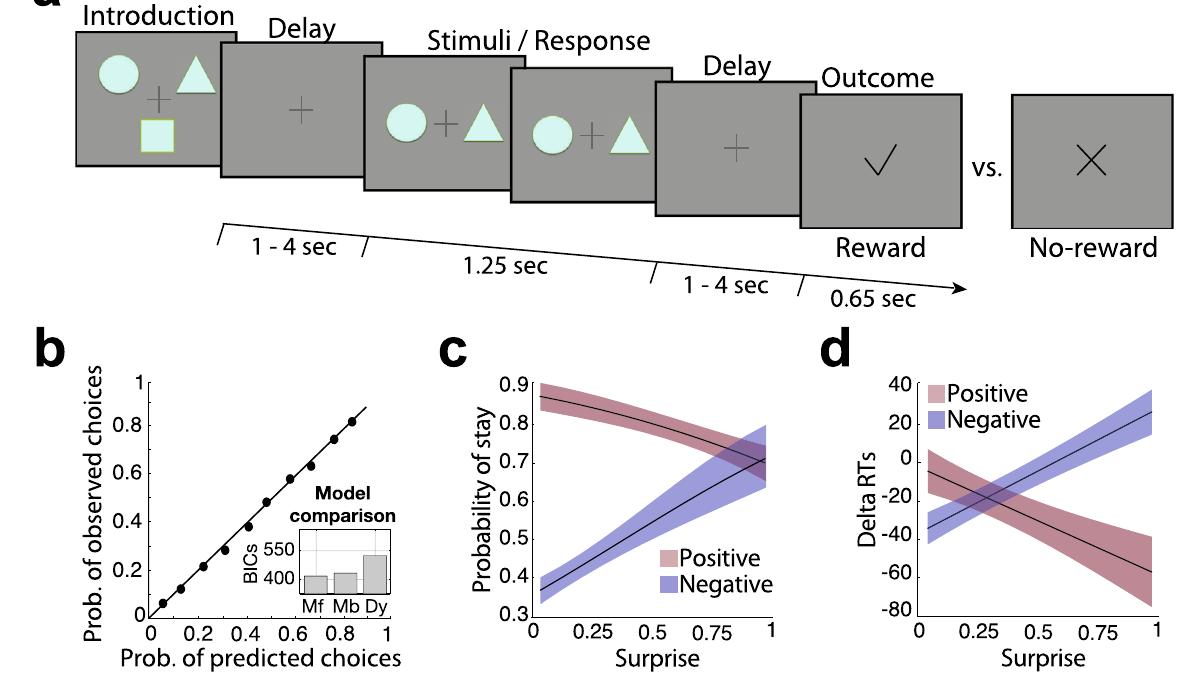
Figure 1. Schematic representation of the experimental task and modeling of behavioral responses. ( a ) Each trial began with a random delay followed by the presentation of two abstract symbols (selected from a larger set of three symbols) for a period of 1.25 s. During this time, subjects pressed one of two buttons on a response device to indicate which of the two symbols (right or left) they believed was more likely to lead to a reward. The fixation cross flickered for 100 ms when a selection was made. Finally the decision outcome was revealed after a second random delay. A tick or a cross were used to inform the participants of a positive or a negative outcome, respectively. ( b ) Main panel: Model-predicted choice probabilities (x-axis) derived from a RL algorithm using a softmax procedure (binned into ten bins – bin size of 0.1 - and averaged across all subjects and across symbols) closely matched participants observed behavioral choices (y-axis), calculated for each bin as the fraction of trials in which they chose one of the three symbols. Small panel: A Bayesian model comparison using BIC scores revealed that the Model-free (Mf) RL model explained the data better than a Model-based (Mb) RL model and a model including a dynamic learning rate (Dy) (Lower BIC scores indicate a better fit – see Methods). ( c ) A mixed-effects regression analysis demonstrated that participants were more likely to repeat the same choice after positive compared to negative feedback with a significant interaction between RPE valence and surprise (see text for details). ( d ) A mixed-effects regression analysis revealed that positive and negative RPEs speed up and slow down reaction times on subsequent trials (Delta RTs = RTs(t + 1) − RTs(t)) respectively, with a significant interaction between RPE valence and surprise (see text for